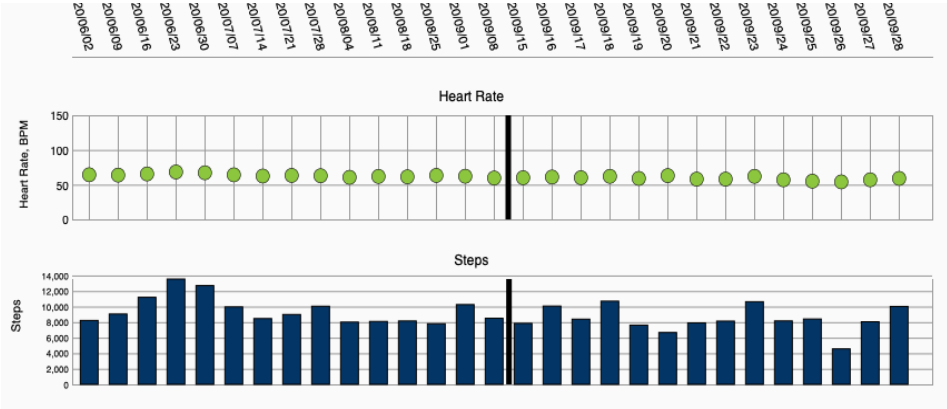
Figure 1. Heart failure parameters heart rate and step count, displayed via remote moni- toring.